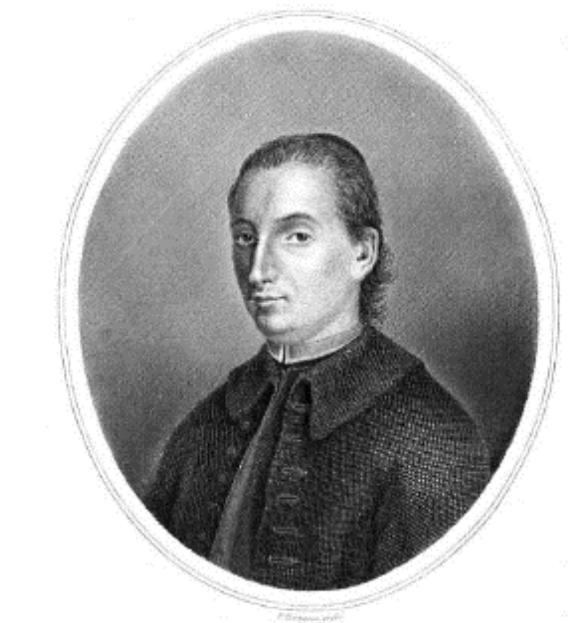
Figure 3. Portrait of José de Viera y Clavijo (1731–1813), ob- server of the aurora from San Cristóbal de la Laguna (Canary Is- lands) on 18 January 1770 (Source: http://bdh-rd.bne.es/viewer.vm? id=0000042056andpage=1 (last access: 6 October 2018), Biblioteca Nacional